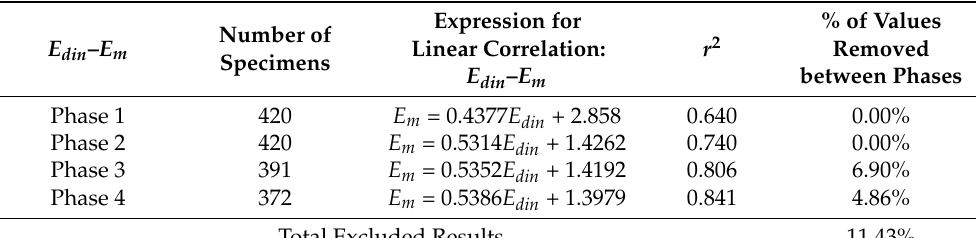
Figure 6. Correlation between dynamic modulus of elasticity ( E din ) and modulus of elasticity ( E m ). ( a ) With the moisture content at the time of the tests (Phase 1); ( b ) After the correction for a 12% of moisture content (Phase 2); ( c ) After excluding the outliers (Phase 3); ( d ) After excluding 5% of the values farthest from the linear regression expression. Table 7. Correlation between dynamic modulus of elasticity ( E din ) and modulus of elasticity in bending ( E m ).